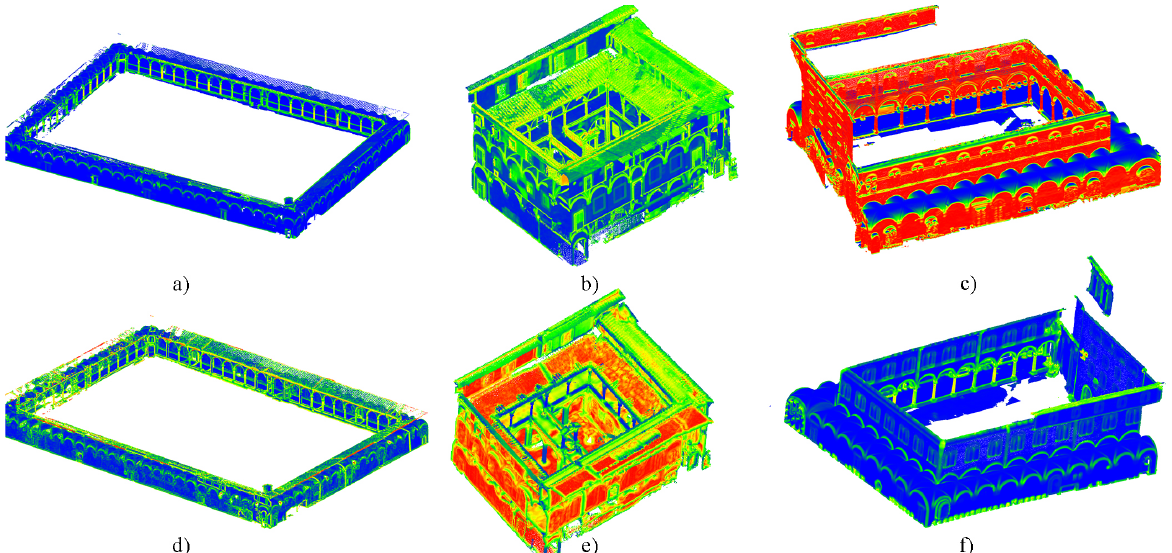
Figure 3. Examples of geometric features: normal change rate (0.4, a) and linearity (0.4, e) for the Grand cloister; omnivariance (0.2, b) and planarity (0.6, e) for the Grand-Ducal cloister; verticality (0.2, c) and surface variation (0.4, f) for the National Museum of S.